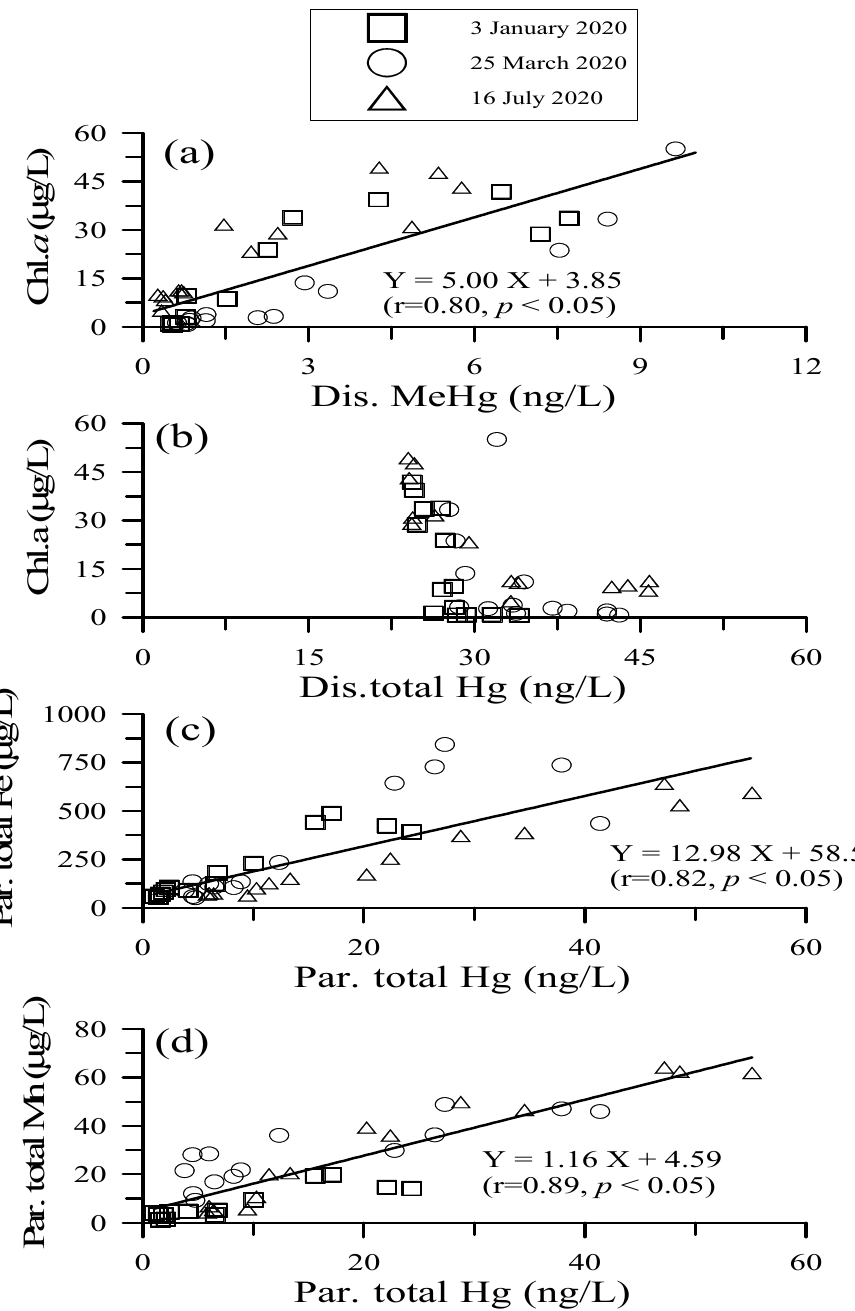
Figure 6. Scatter plots of ( a ) chl. a against dissolved MeHg, ( b ) Chl. a against dissolved total Hg, ( c ) particulate total Fe against particulate total Hg, ( d ) particulate total Mn against particulate total Hg concentration in the Danshuei River Estuary, northern Taiwan.